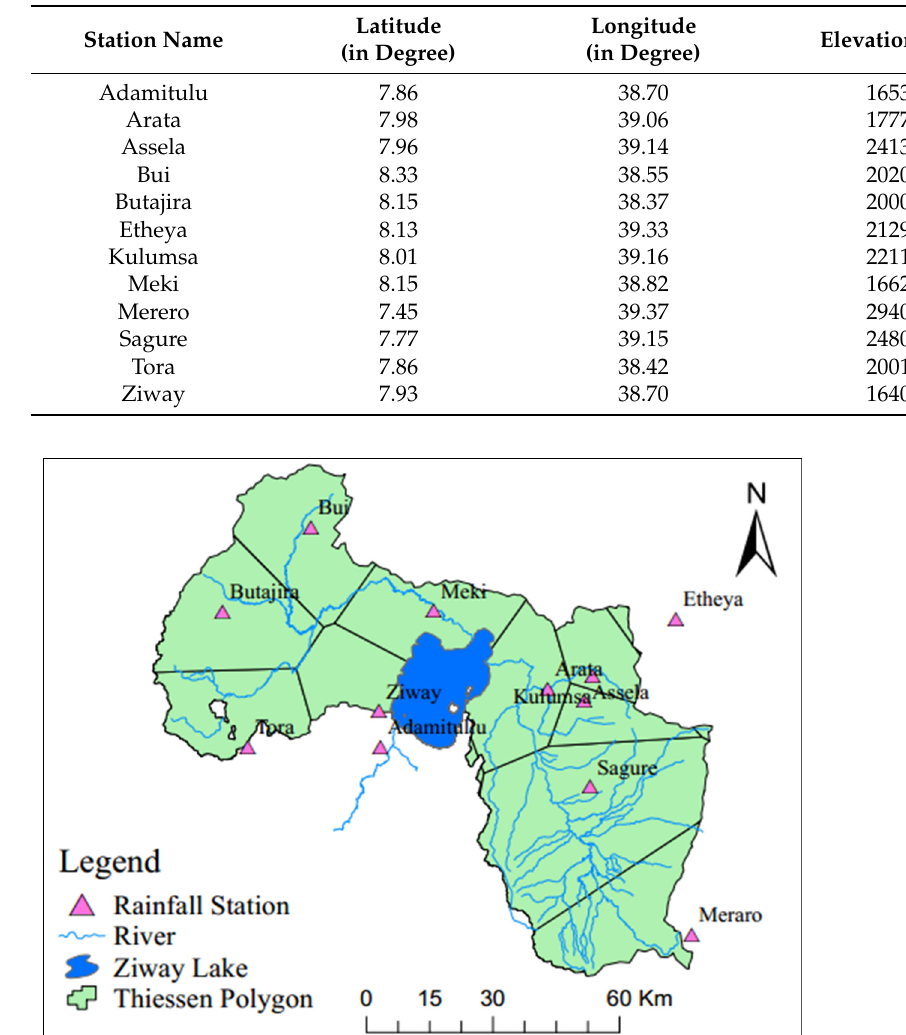
Figure 2. Thiessen Polygon network of the Ziway Lake Basin.